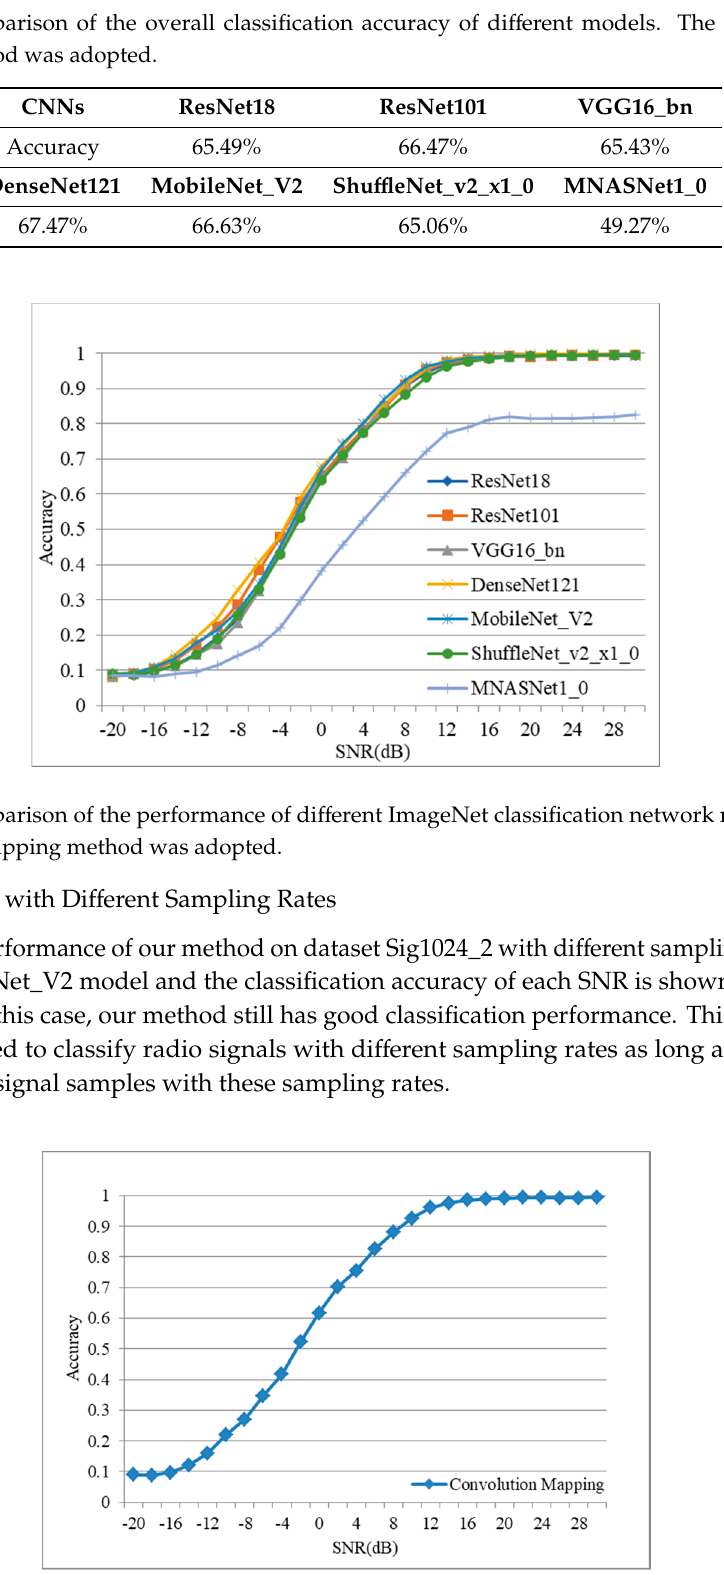
Figure 8. Classification accuracy of each SNR of the real dataset RealSig. The classification method is CMM and the CNN model used is MobileNet_V2. To further improve the performance, we add the training set in dataset RealSig to fine-tune the model MobileNet_V2 trained with dataset Sig1024 with a learning rate of 0.00001, and then test the model’s classification performance on the test set. The classification accuracy of each SNR is shown in Figure 9. We can see that the classification accuracy can be improved to nearly 100% at high SNR.